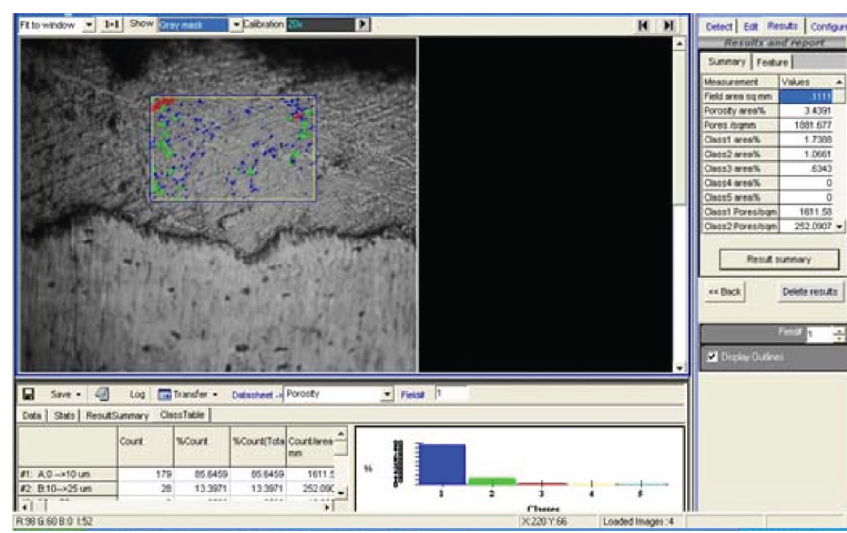
Figure 3: Measure the porosity level using computer image analysing